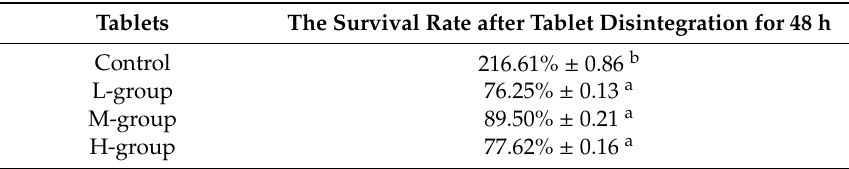
Table 4. The survival rate of lactobacilli cells after tablet disintegration for 48 h. Tablets The Survival Rate after Tablet Disintegration for 48 h